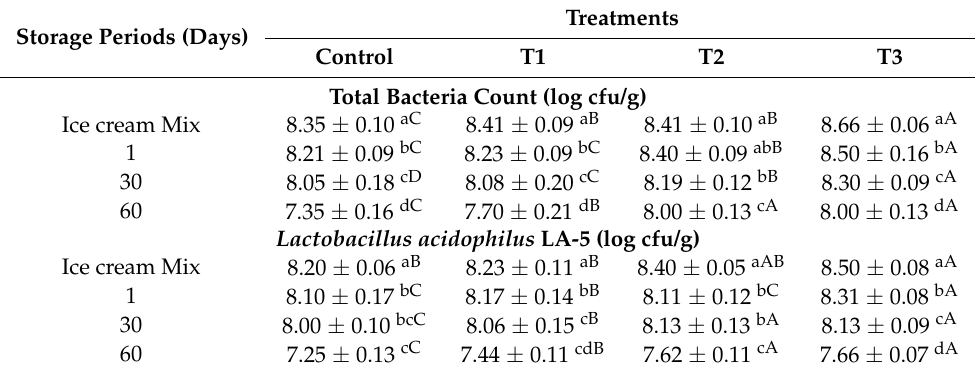
Table 4. Viability of L. acidophilus LA-5 in ice cream during storage periods at freezing temperature (log